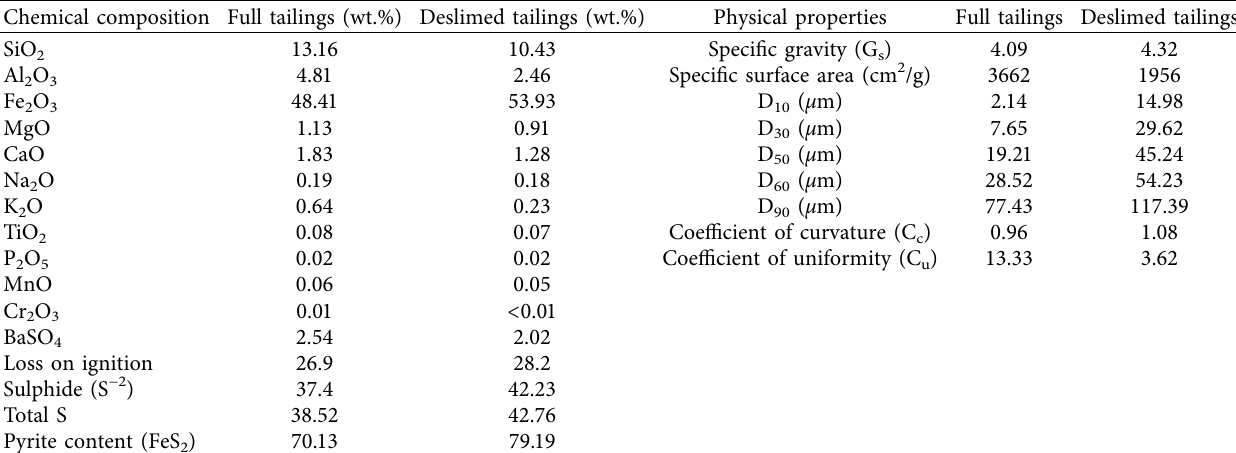
Table 1: Physical, chemical, and mineralogical properties of tailings.